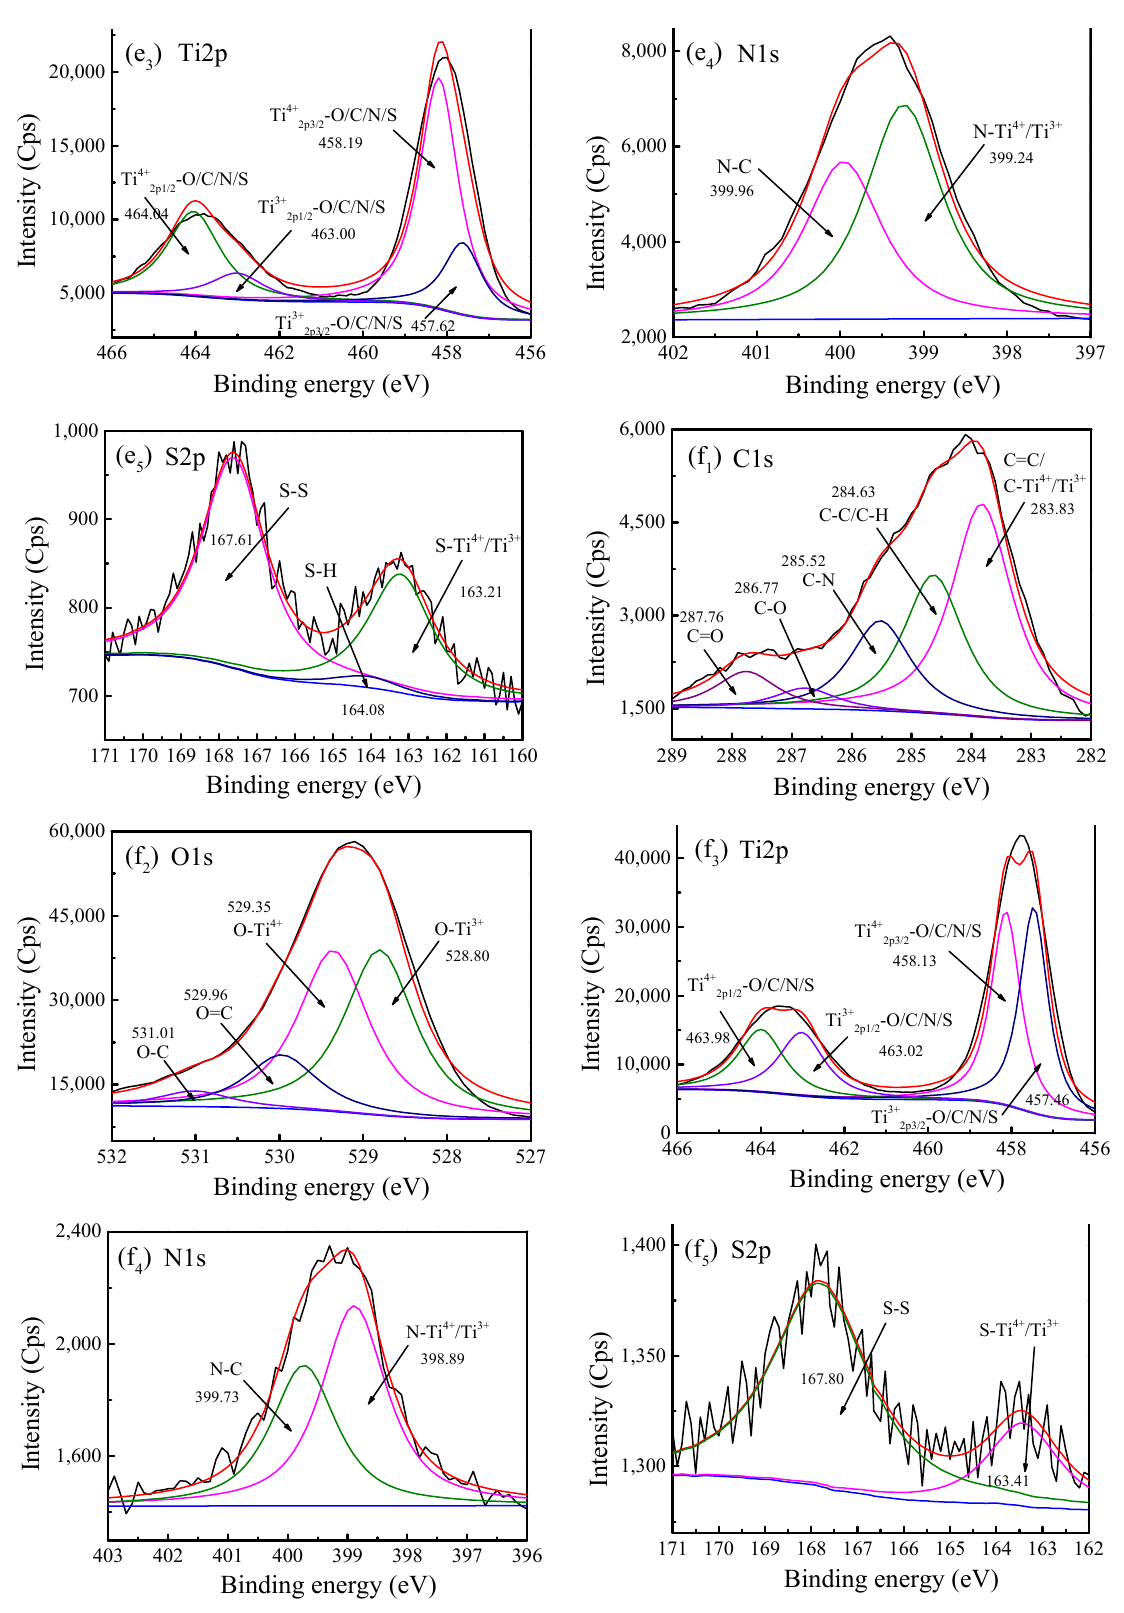
Figure 6. The ( a ) XPS survey spectra, ( b ) comparison of elemental compositions, and high-resolution XPS spectra for the TiO 2 films ( c ) before and ( d ) after calcination, and keratin char-TiO 2 composite films ( e ) before and ( f ) after calcination (Note: the low corner codes of 1, 2, 3, 4 and 5 stand for the C 1s , O 1s , Ti 2p , N 1s, and S 2p , respectively.).